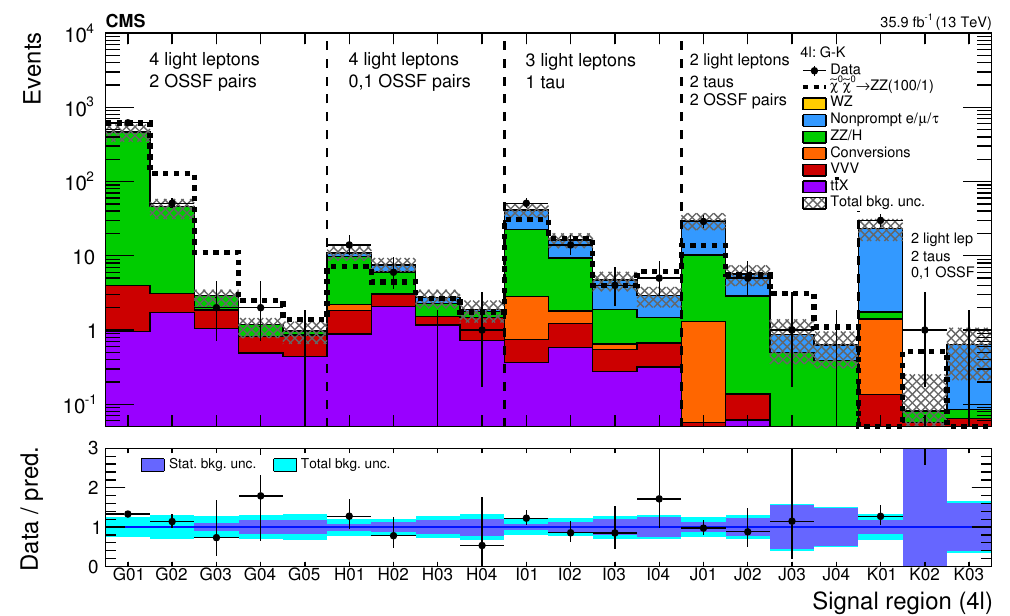
Figure 12 . Expected and observed yields comparison in signal regions with at least four leptons (categories G{K). An example mass point in the illustration. The notation is analogous to that used in (cid:12)gure 7.